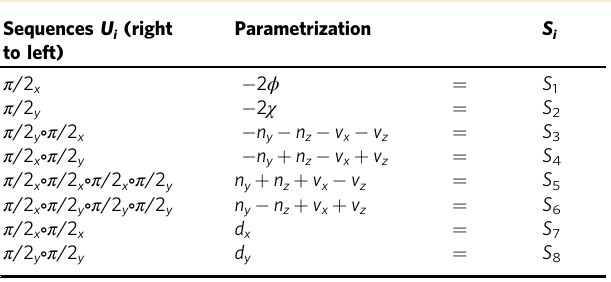
Table 1 Tomographic gate sequences. Sequences U i (right to left)